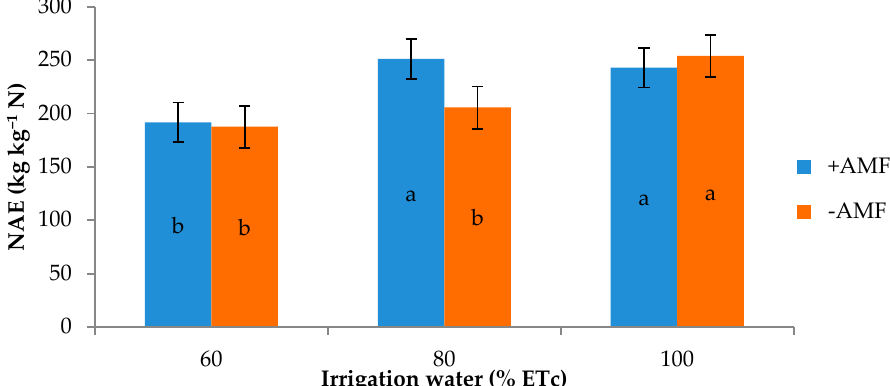
Figure 8. Effect of irrigation treatments and plant inoculation with arbuscular mycorrhizal fungi (AMF) on nitrogen applied efficiency (NAE) of melon plants during two years of experiments (bars with different letters are significantly different at p < 0.05 according to the LSD test). The relationship between the relative yield (yield/maximum yield) of the mycor- rhized and non-mycorrhized plants and the volume of irrigation water (% ETc) is shown in Figure 9. The regression analysis found a linear function for the uninoculated plants and a second-degree polynomial function for inoculated plants; these functions were sig- nificant ( p < 0.001 and p < 0.01 for uninoculated and inoculated plants, respectively), and had a high coefficient of determination (R 2 ), but showed different trends according to plant inoculation.